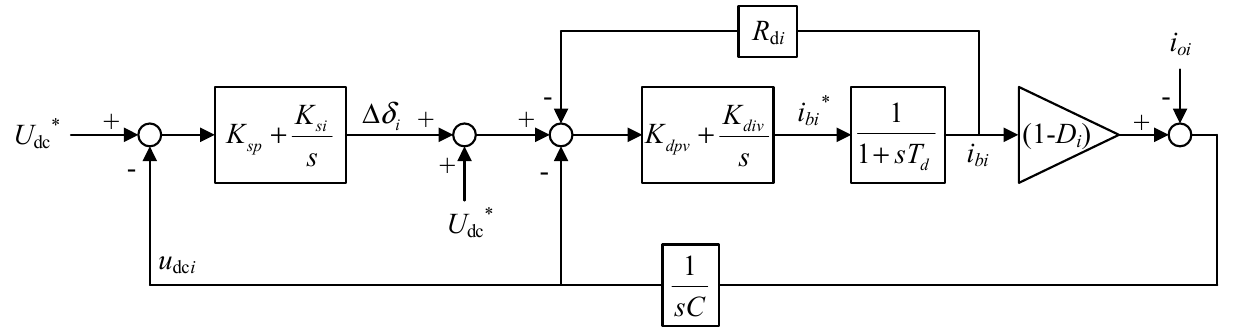
Figure 6. Control loop modelling of DC/DC converter.